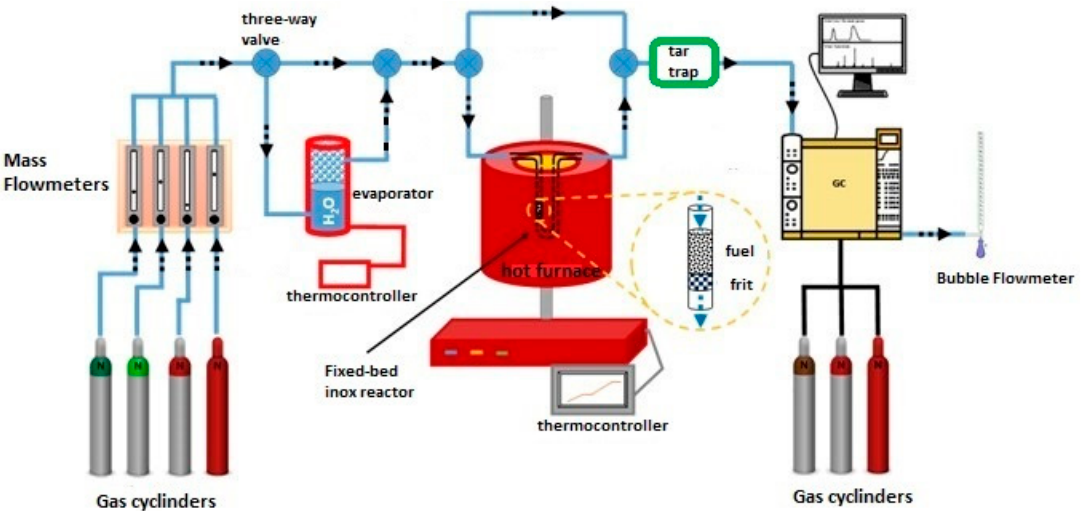
Figure 9. Experimental apparatus of the lab-scale CO 2 -gasification experiments.